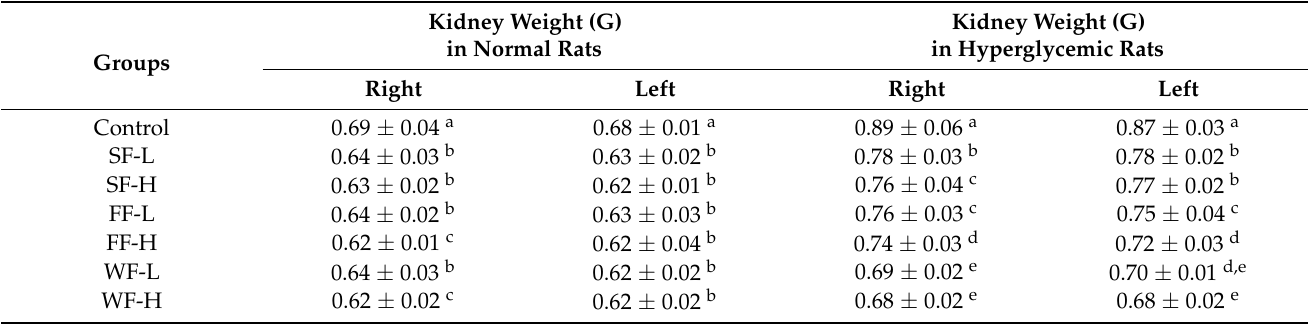
Table 6. Impact of bitter melon supplementation on kidney